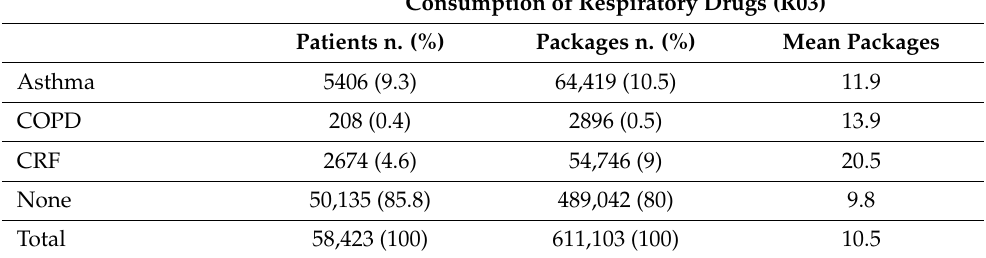
Table 4. The consumption of respiratory drugs (packages) in patients with specific exemption codes, those without exemption code, and those with other exemption codes. Consumption of Respiratory Drugs (R03) Patients n. (%) Packages n. (%) Mean Packages Asthma 5406 (9.3) 64,419 (10.5)